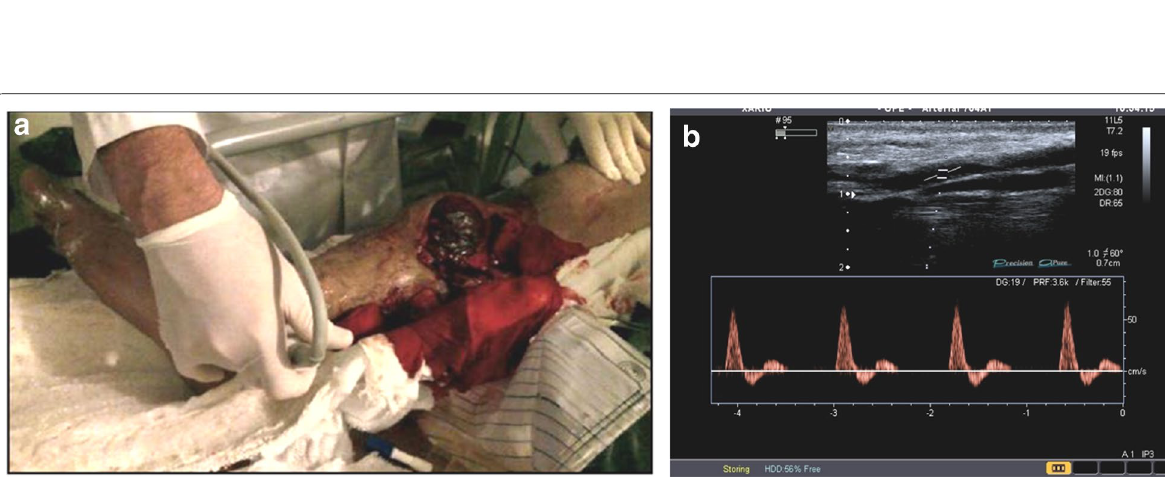
Fig. 19 Open fracture of the tibia. a Displaced long bone fracture with segment exposure. Exploration of distal pulses. b Normal triphasic